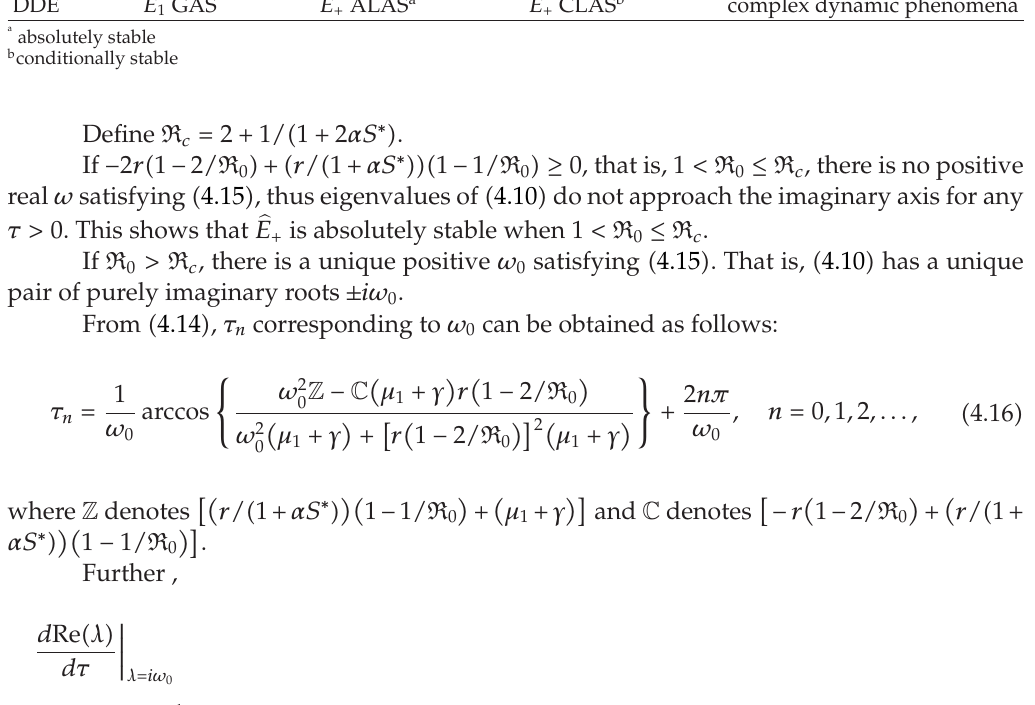
complex dynamic phenomena